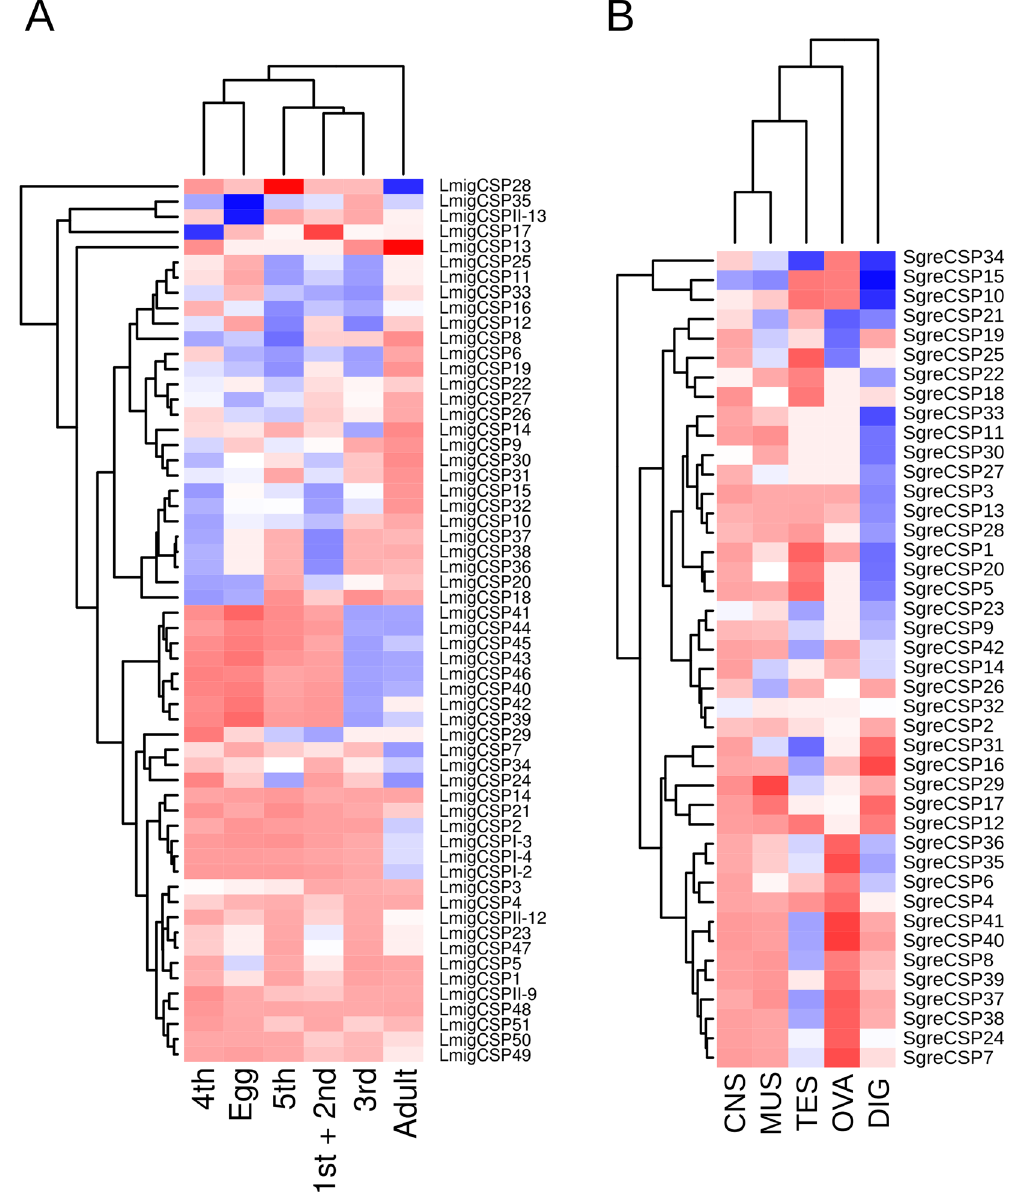
Figure 4. Solitarious to gregarious expression profiles of the locusts’ CSPs identified in the present work. ( A ) Comparison between L . migratoria ’s nymphal instars and adults. ( B ) Comparison between S . gregaria ’s tissues. The expression levels are shown as color hues proportional to the 2-based logarithm of the fold change (see Methods). Blue hues represent solitarious over-expression whereas red hues represent gregarious over-expression. The hues become lighter as the differences of the expression levels between solitarious and gregarious phases become weaker, and white hues represent non-differential expression. Dendrograms group the samples and CSPs based on similarity of the expression profiles. CNS = central nervous system, MUS = muscle, DIG = digestive tube, OVA = ovaries, TES = testicles. 1st + 2nd, 3rd, 4th and 5th in ( B ) indicate the nymphal